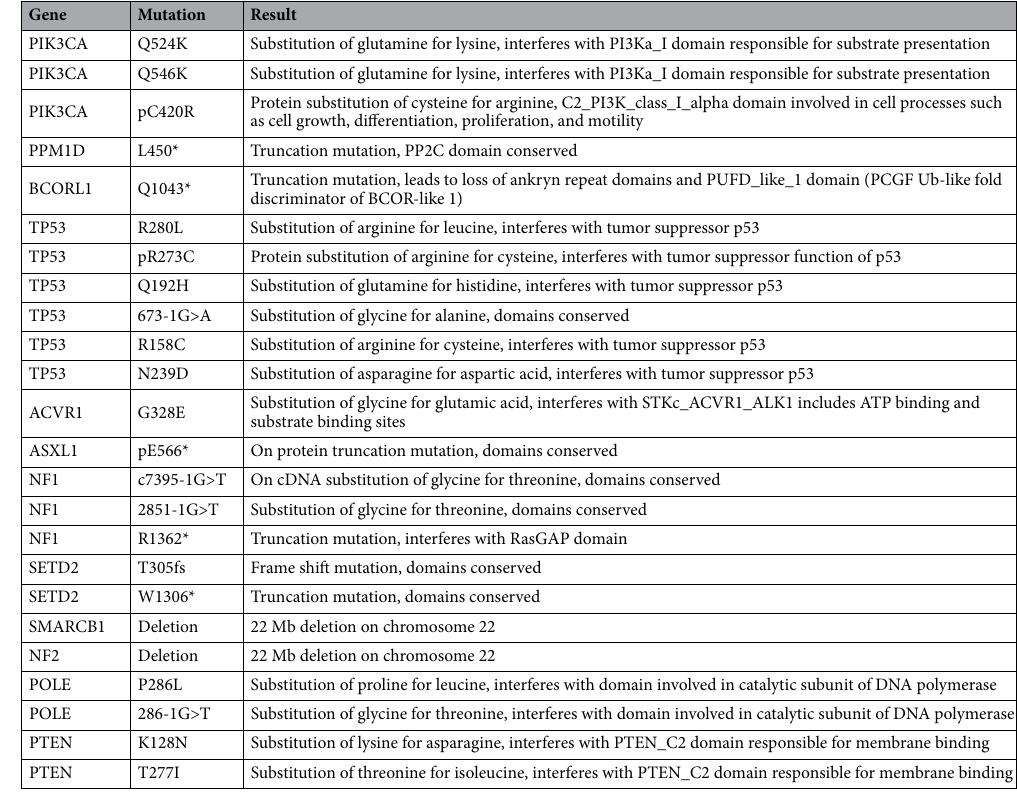
Table 1. Mutations identified within diffuse midline gliomas and hemispheric gliomas and their effect on protein